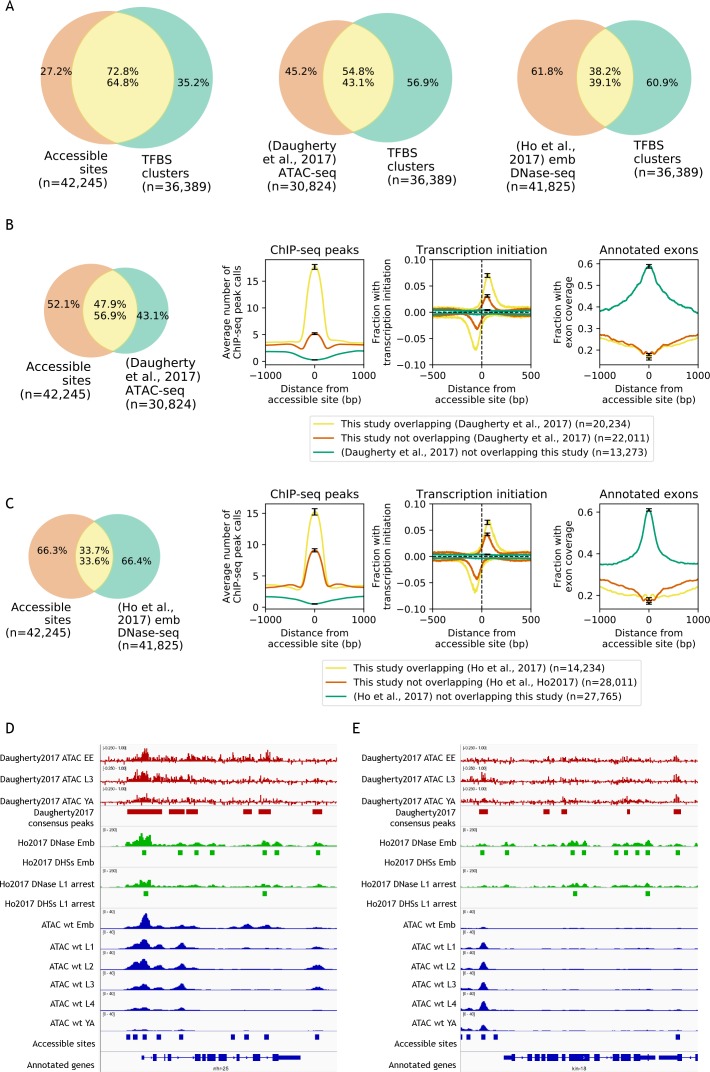
Comparisons to previous accessibility maps.(A) Venn diagrams showing the overlap of transcription factor binding sites defined by clustering modENCODE/modERN peak calls (n = 36,389; Materials and methods) to accessible sites from this study and two previous studies (Daugherty et al., 2017; Ho et al., 2017). (B) Comparison of accessible sites defined in this study to accessible sites defined in Daugherty et al. (2017). (C) Comparison of accessible sites defined in this study to accessible sites defined in Ho et al. (2017). (B,C) Leftmost plot shows overlaps between accessible sites. Rightmost three plots compare regions found in both studies or unique to only one study, for mean profile of modENCODE/modERN peak call pileup, fraction of sites with transcription initiation signal (negative values are reverse strand signals), and fraction overlapping an exon. (D,E) IGV screenshots (D: nhr-25, chrX:13,007,000–13,015,000, 8 kb; E: kin-18, chrIII:6,117,000–6,125,500, 8.5 kb) of stage-specific accessibility profiles and peak calls from Daugherty et al. (2017) (top, red), (Ho et al., 2017) (middle, green), and this study (bottom, blue).